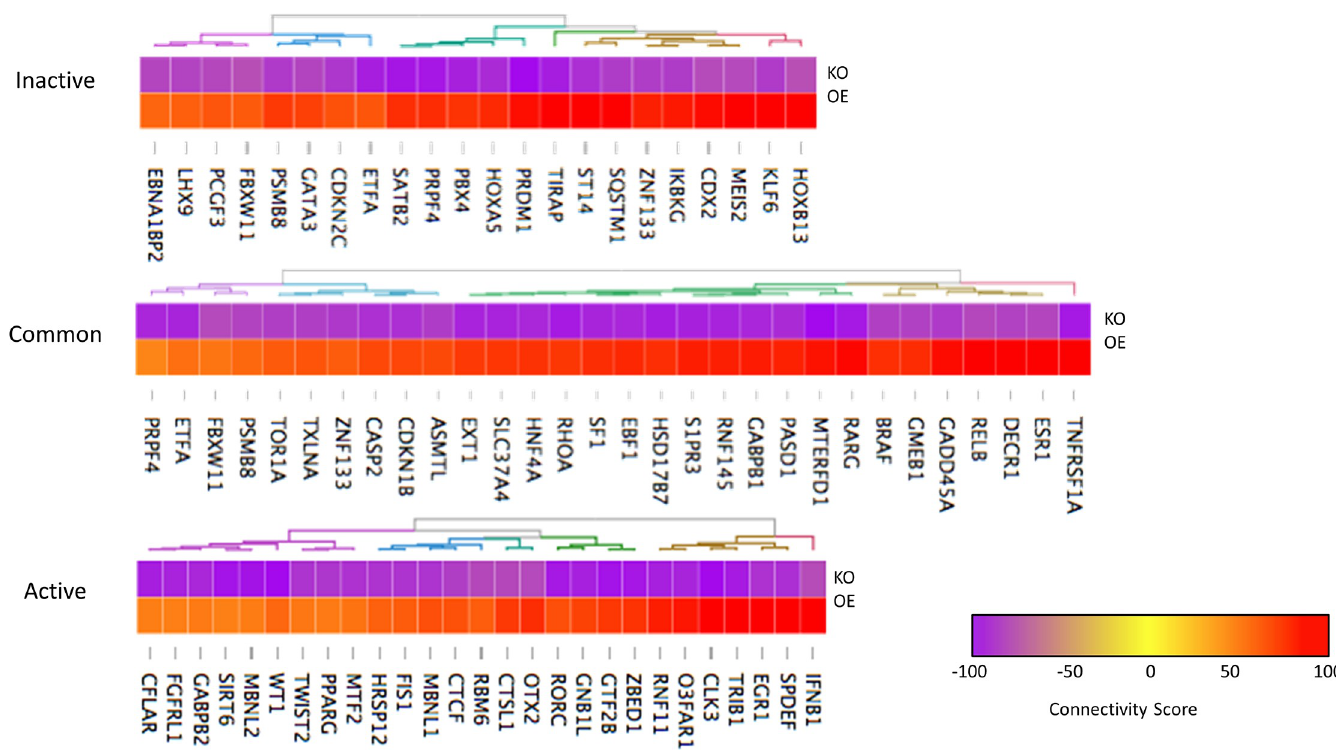
Fig 6. LINCS biological upstream regulators. Gene sets from CD14 + MC isolated from active or inactive SLE patients were used as input for the LINCS analysis platform, which reports connectivity scores for individual genes that describe how well the genomic change between the baseline and experimental input sets matches the change observed following the knockdown or overexpression of the individual gene in question. Knockdown and overexpression data were filtered by genes for which LINCS reported connectivity scores for both categories, and genes were identified as BURs for a particular dataset if they received a knockdown connectivity score between -75 and -100 and an overexpression connectivity score between 50 and 100 for that dataset.